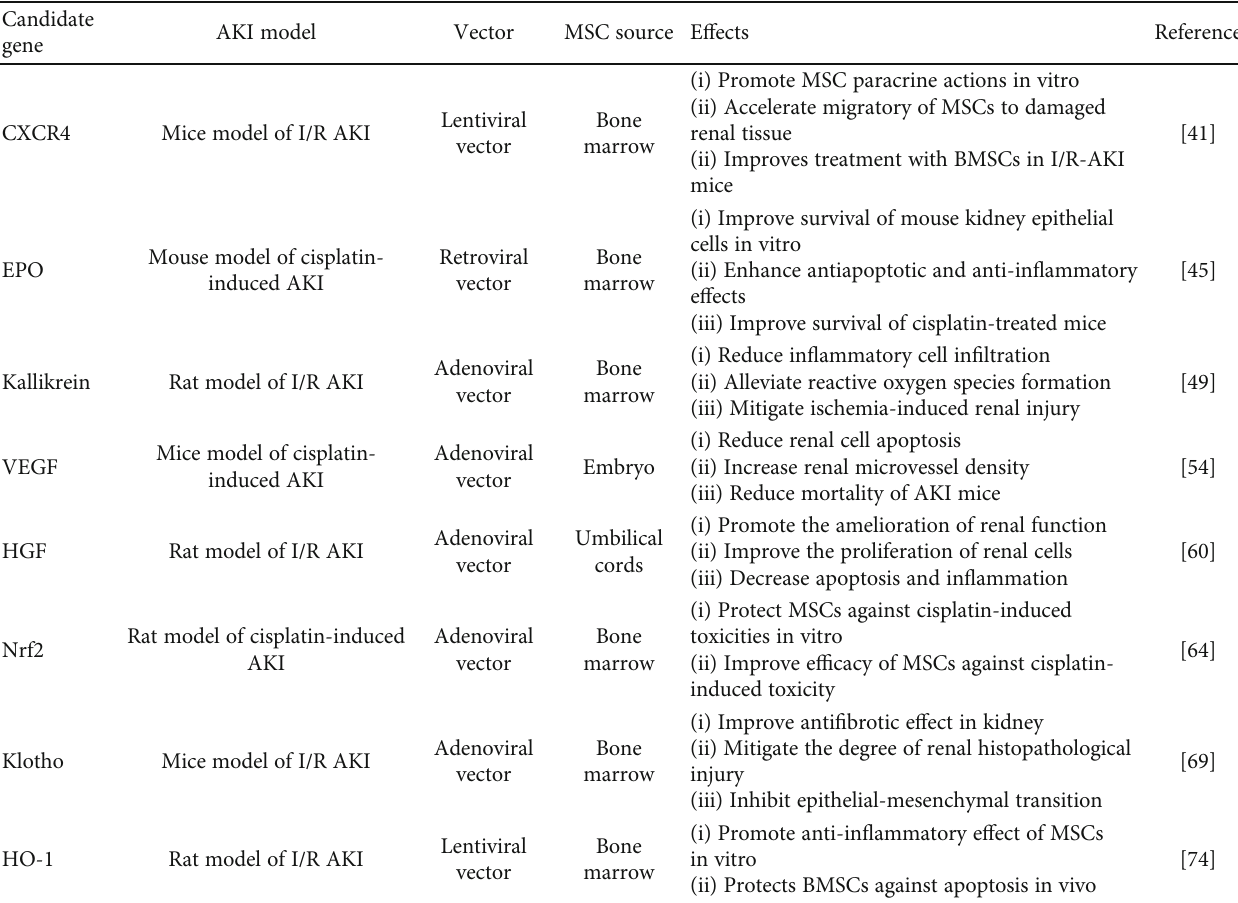
Table 2: Research regarding the application of gene-modi fi ed MSCs in preclinical AKI